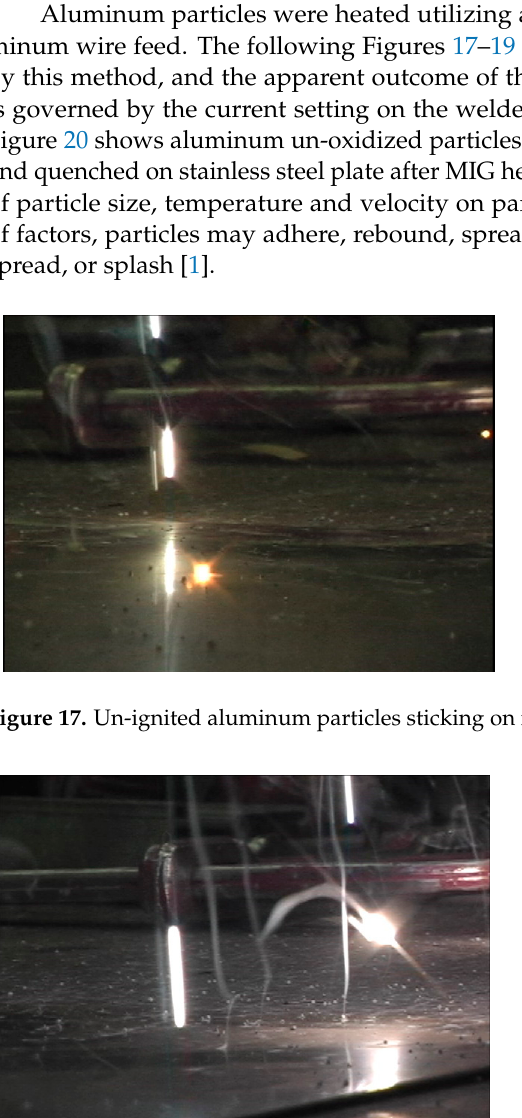
Figure 18. Ignited aluminum particles (based on white smoke following particles) rebounding fol- lowing impact on a SS plate and not quenching.